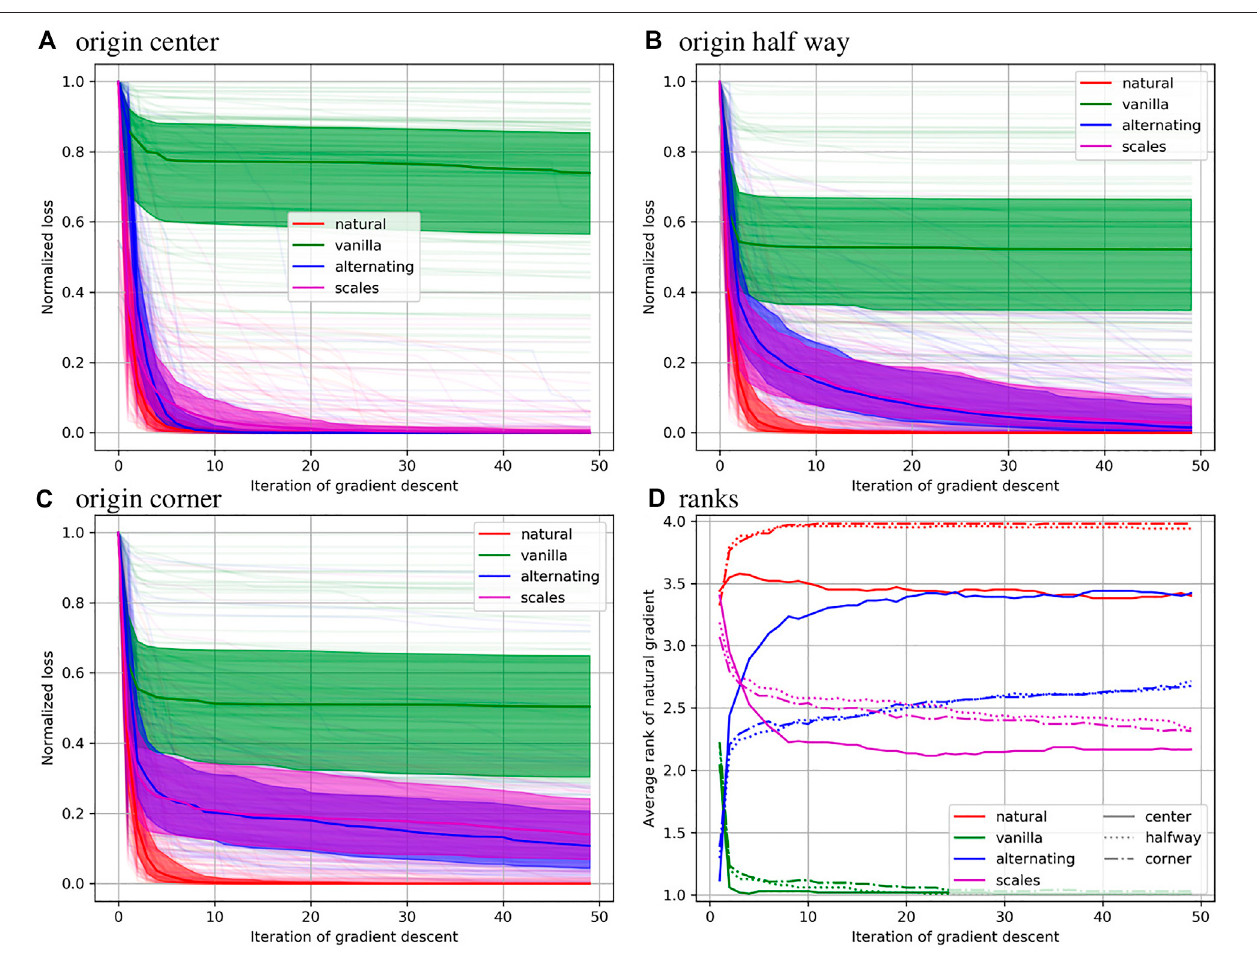
FIGURE 6 | Results of minimizing sum of square error over 6 parameter rigid registrations are shown with the coordinate origin in the center (A) , half way to the corner (B) , and in the corner (C) . In these plots the normalized value of the objective function is shown at each iteration of gradient based optimization. In (D) the rank of each method is shown under each of these